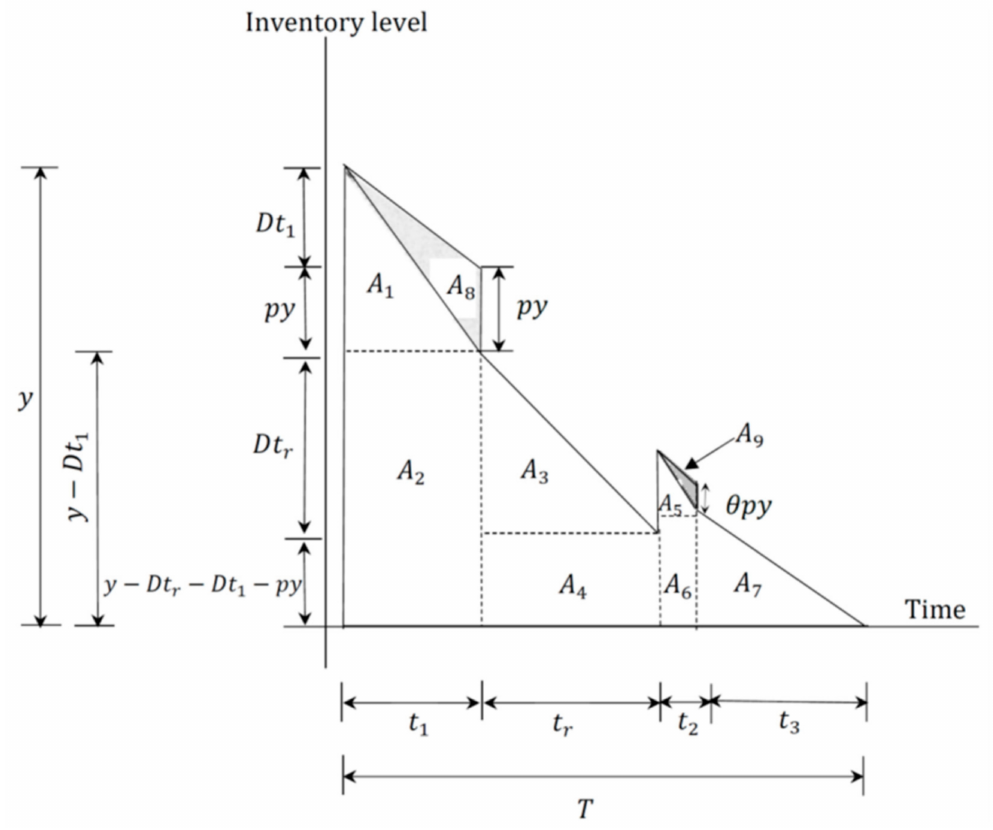
Figure 1. Inventory level through time for Case 1. The reworked lot arrives when there exists